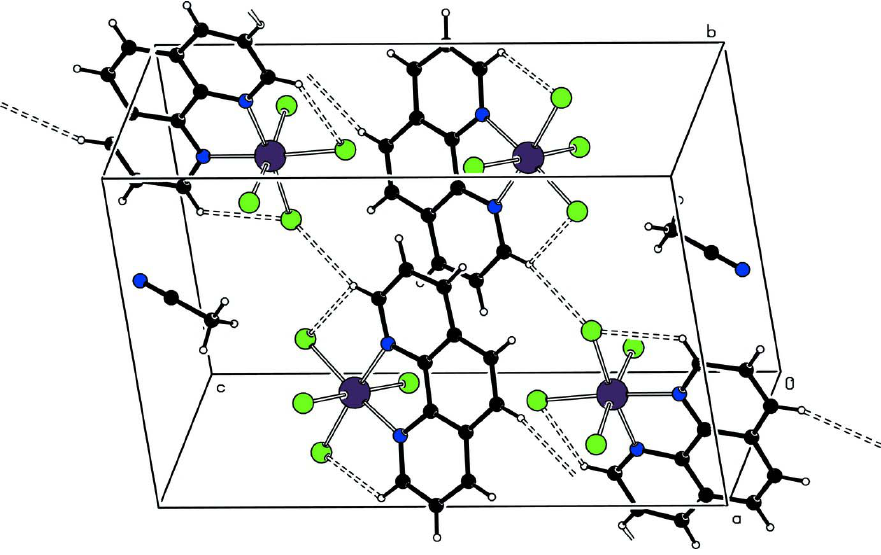
The structure of the title compound, with displacement ellipsoids drawn at the 30% probability level for non-H atoms.